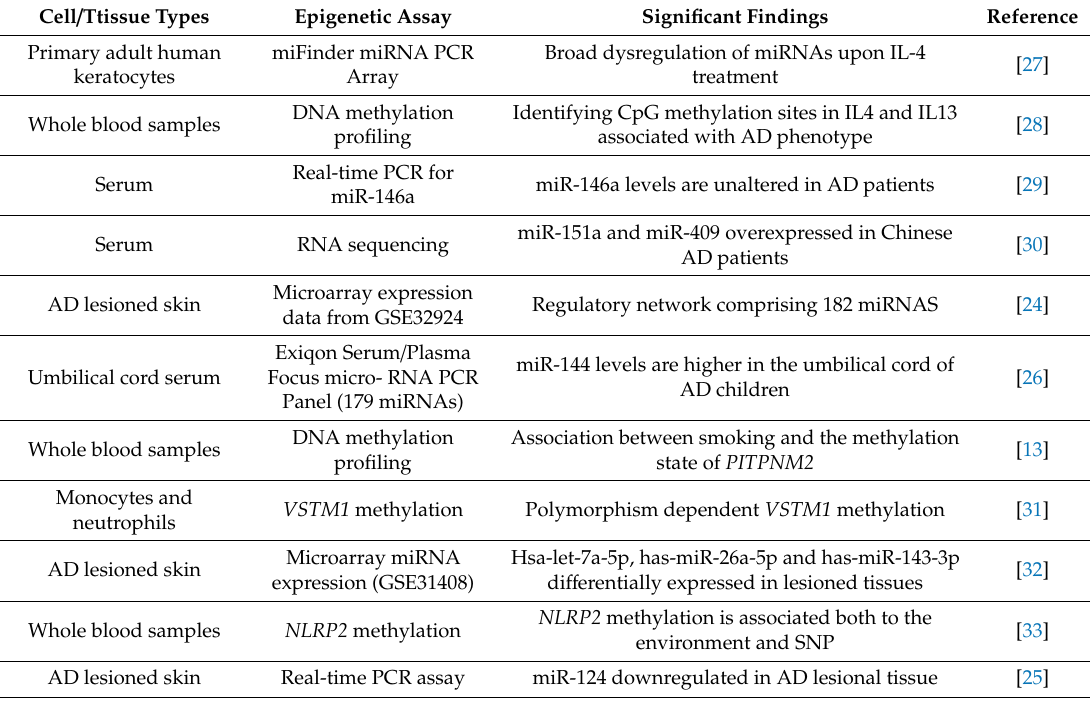
Table 2. Summary of findings from the selected epigenetic